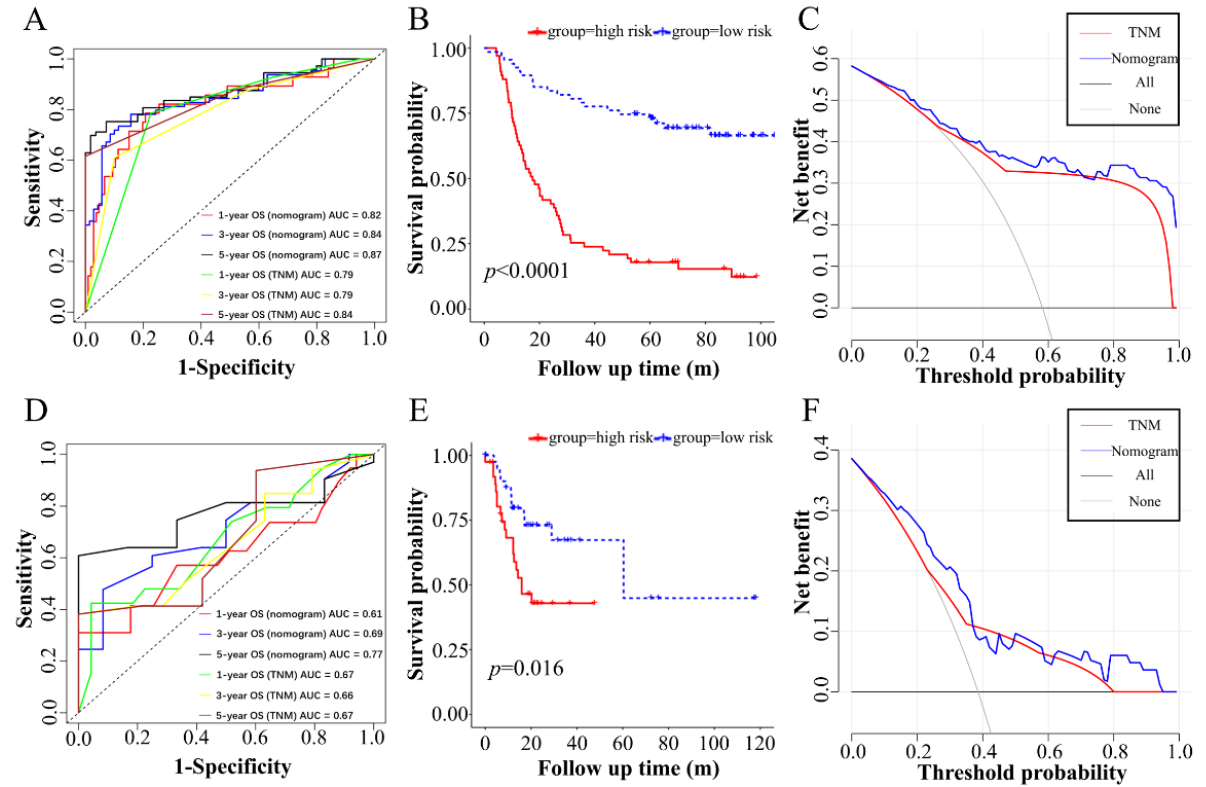
Figure 5. ( A ) Receiver operating characteristic (ROC) curves were used to compare the predictive ability of nomogram model and TNM stage for 1-, 3- and 5-year survival probabilities in training set. ( B ) The Kaplan – Meier curve shows the high-risk group with worse prognosis in training set. ( C ) Decision curve analysis of nomogram in training set for OS. ( D ) The ROC curves of nomogram in external validation set (TCGA-STAD). ( E ) Kaplan – Meier analysis of high-risk group and low-risk group in external validation set (TCGA-STAD). ( F ) Decision curve analysis of nomogram in external validation set.